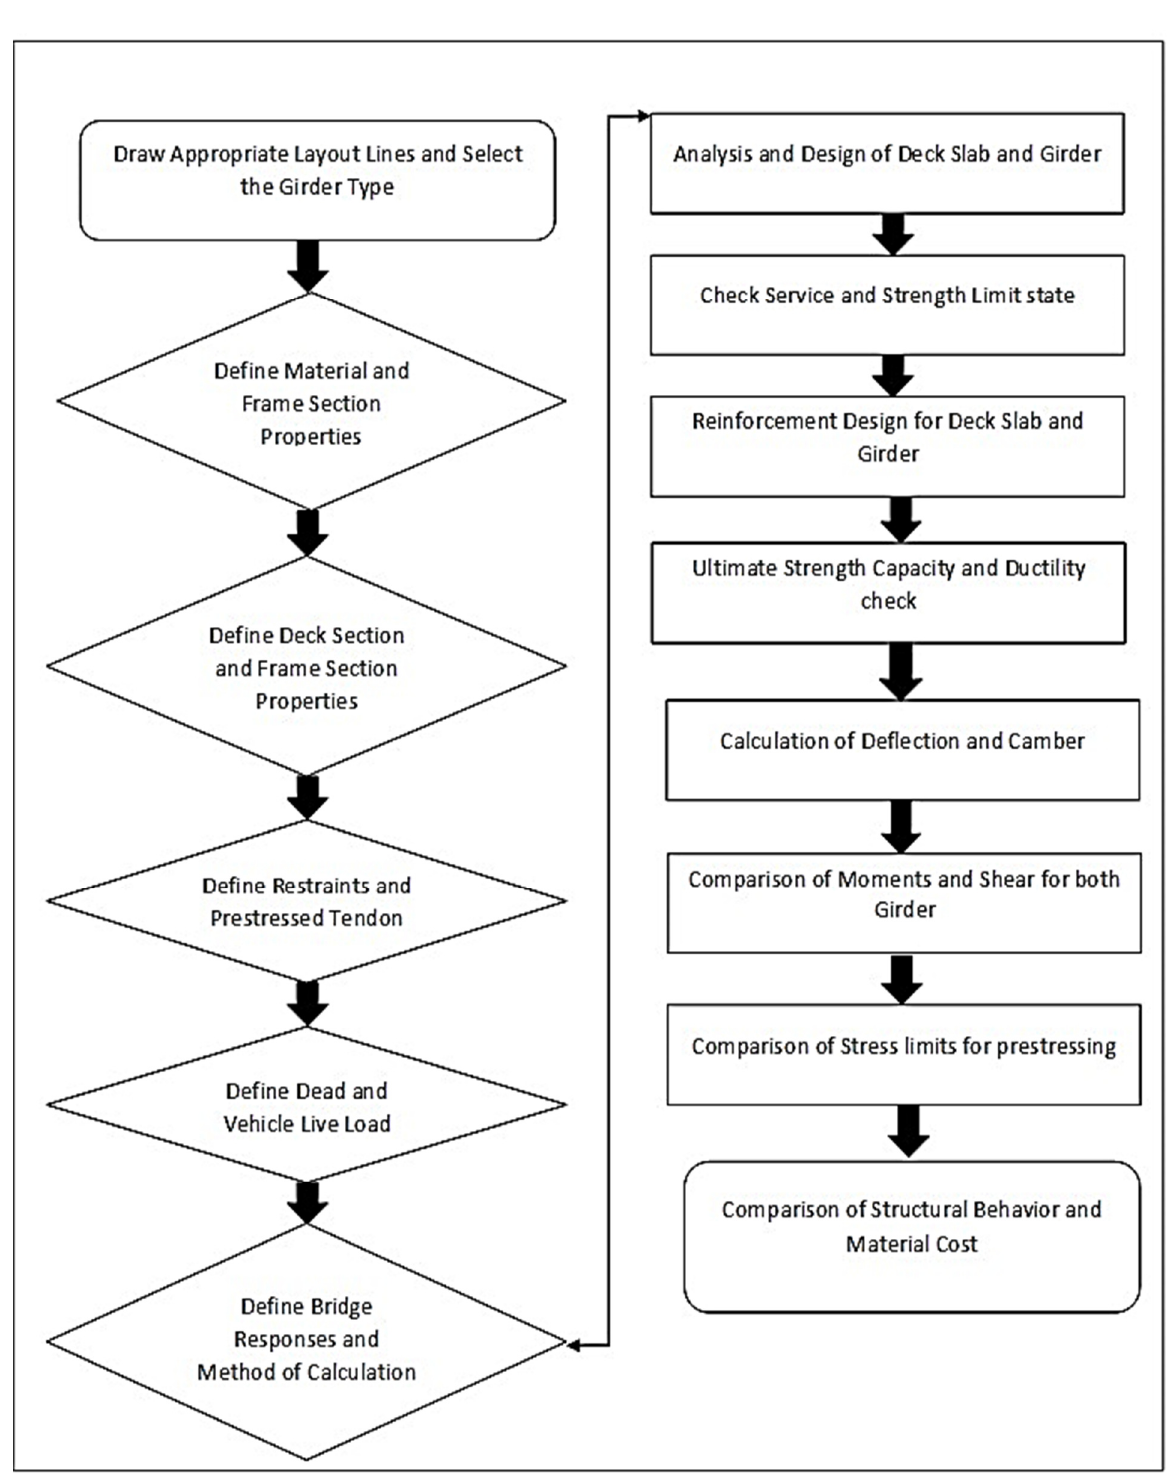
FIG. 7: STEPS FOR ANALYSIS AND DESIGN OF BOX AND T BEAM GIRDER